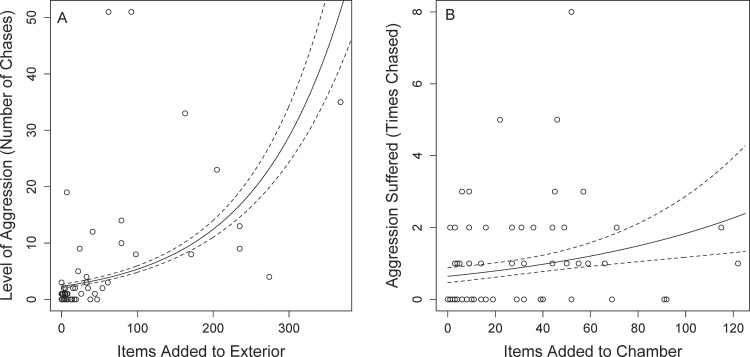
(A) Positive association between the number of items added to the thatch of the nest and the number of chases an individual performed. (B) Positive relationship between the number of items added to a nest chamber and the aggression suffered by the individual. In both plots the solid line is the predicted line from the generalized linear mixed model while the dashed lines represent the 95% confidence intervals around the line.